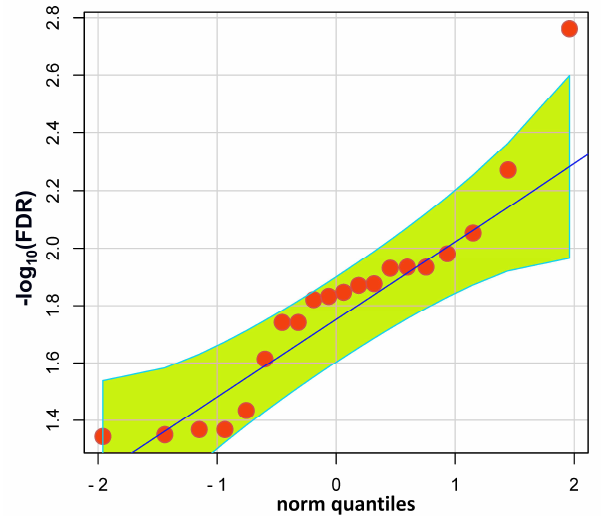
Figure 3. Q–Q plot of SNPs exceeding the 5% significance threshold of —log10-transformed FDR values (>1.3), suggestive of an association with fertility differences in 100 men. The blue diagonal gives the expectation under a normal distribution. The greenish area with turquoise boundaries corresponds to the 95% confidence interval.